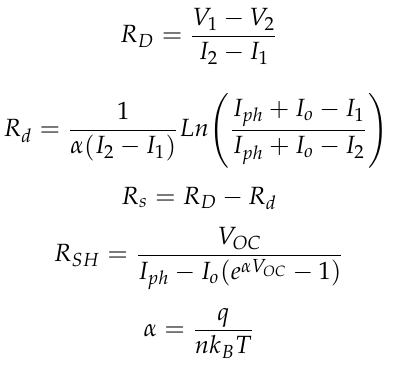
Figure 6. The circuit of a photovoltaic cell [25].